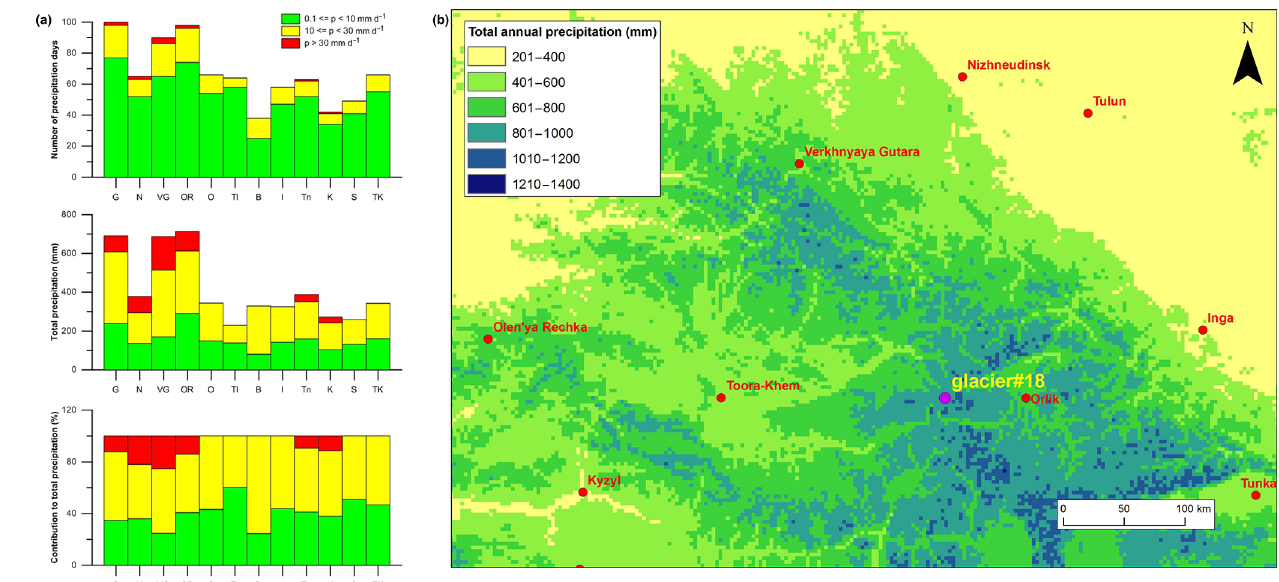
Figure 3. Precipitation regime on the glacier #18 and 11 nearest weather stations (abbreviations correspond to those in Fig. 1) during the observation period 2015–2017 (a) , and long-term annual precipitation map of the study area (b) produced by the authors using the rain gauges data (1964–2017 mean) from the 11